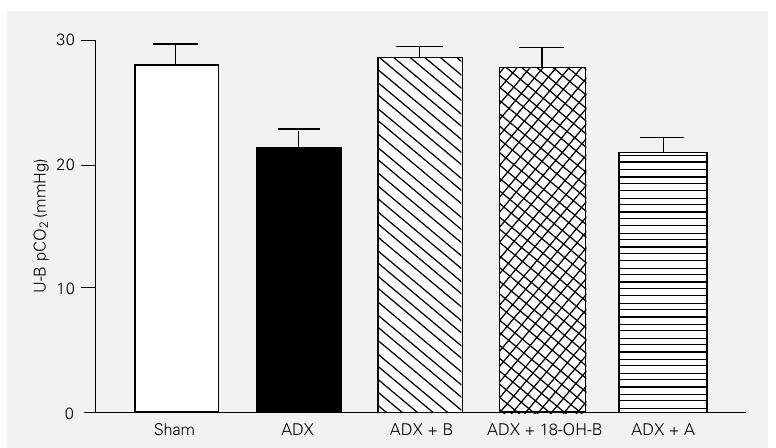
Figure 5 - U-B pCO 2 in amiloride-treated rats. Experimental groups as in Figure 1. Data from Ref. 30, with